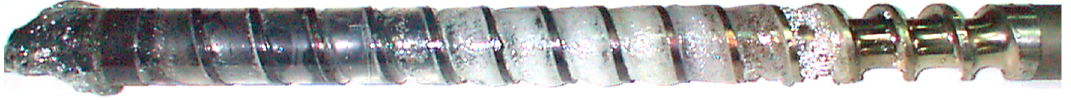
Figure 3. Mechanism of polymer melting in the injection molding machine on an example of injection molding of polystyrene (unpublished).